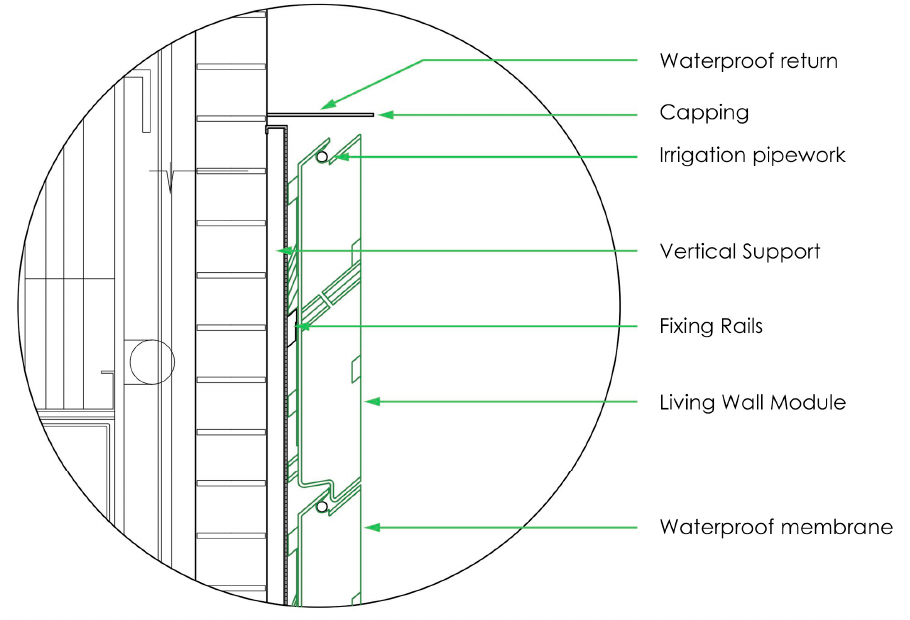
Figure 7. Living wall top section based on